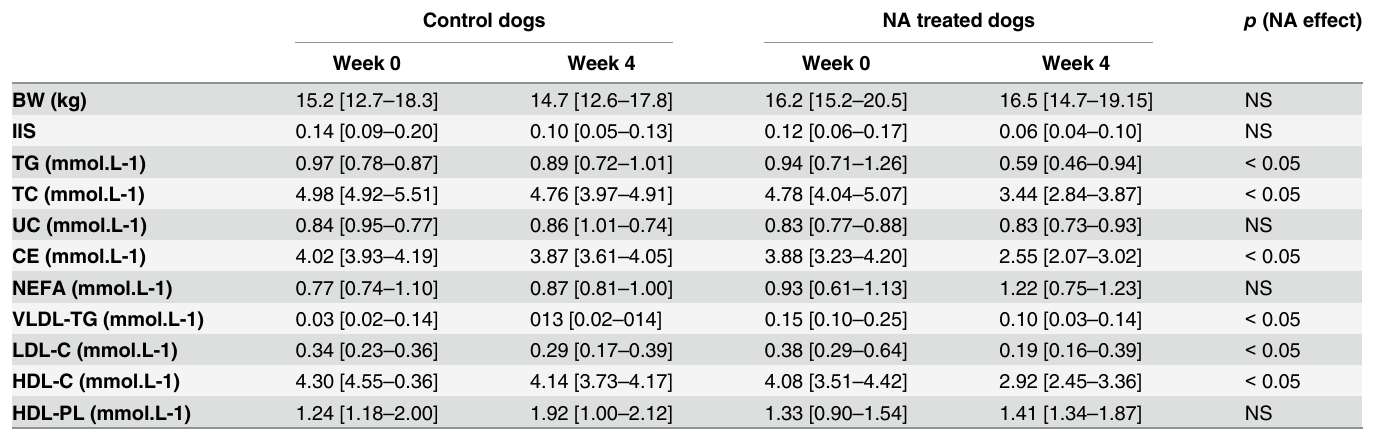
Table 2. Body weight (BW), insulin sensitivity index (I IS ), fasting plasma triglycerides (TG), total cholesterol (TC), unesterified cholesterol (UC), cholesteryl ester (CE), unesterified fatty acid (NEFA), VLDL-triglycerides (VLDL-TG), LDL-cholesterol (LDL-C), HDL-cholesterol (HDL-C), HDL- phospholipids (HDL-PL) in control dogs (n = 3) and in NA-treated dogs (n = 6) before (week 0) and at the end of the treatment (week 4). Values are presented as median [minimum-maximum]. NS, non